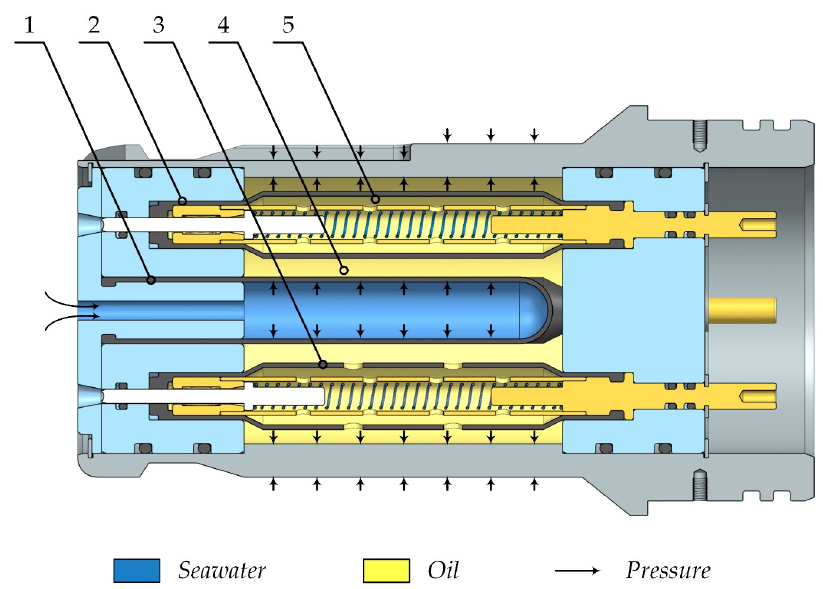
Figure 3. A schematic illustration of the dual-bladder PBOF technology used in the proposed wet- mateable electrical connector: 1-primary resilient bladder; 2-secondary resilient bladder; 3-secondary resilient bladder with through-holes; 4-primary oil chamber; 5-secondary oil chamber.